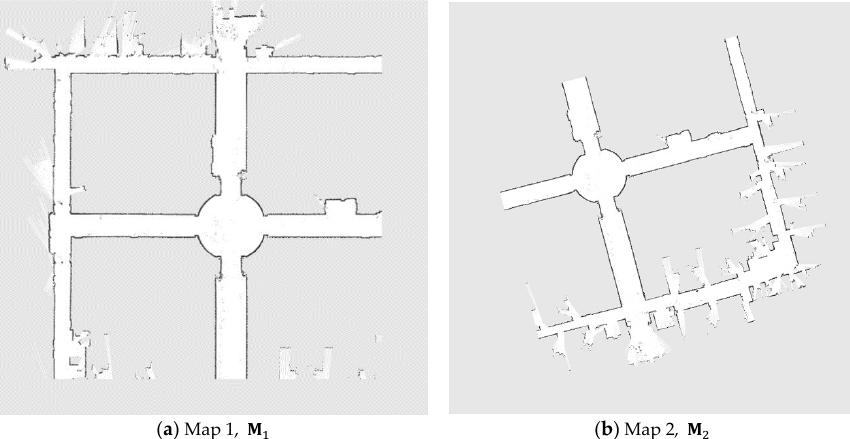
Figure 2. Two individual grid maps ( a ) M 1 and ( b ) M 2 . The black grids, the white grids, and the gray grids represent occupied, unoccupied, and unknown area, respectively. The map transformation matrix between them can be obtained by finding and aligning the overlapped areas between them.